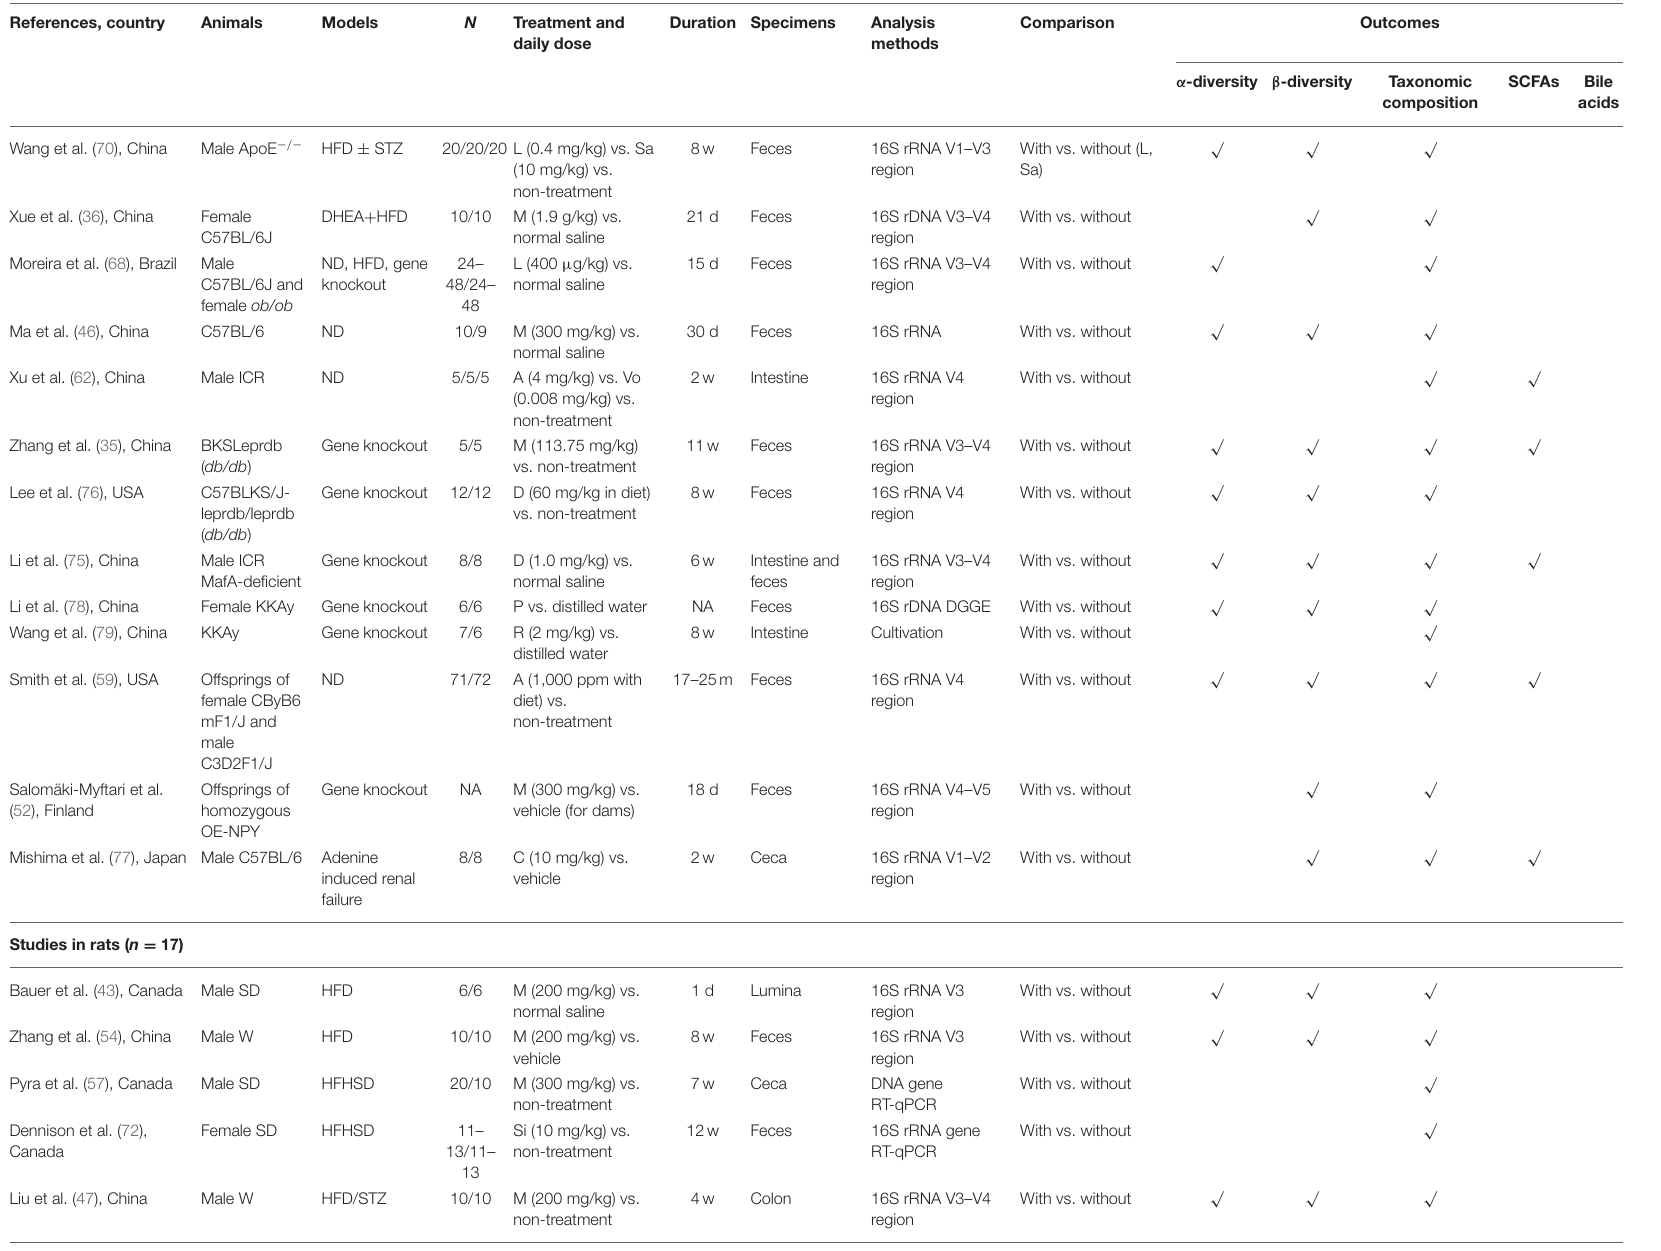
7w Ceca DNA gene With vs. without √ RT-qPCR With vs.